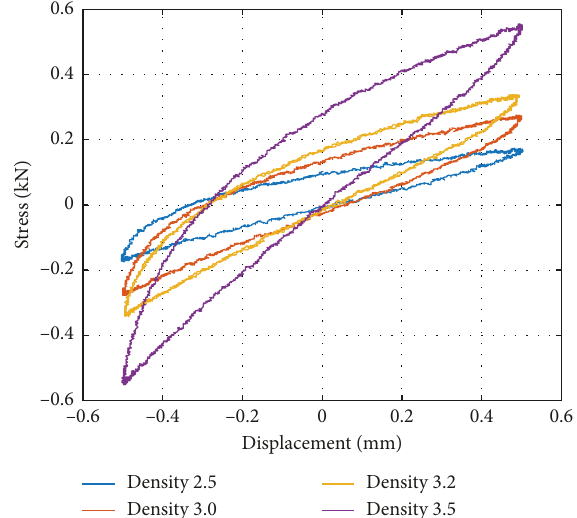
Figure 11: Hysteresis curve of MR with different densities.